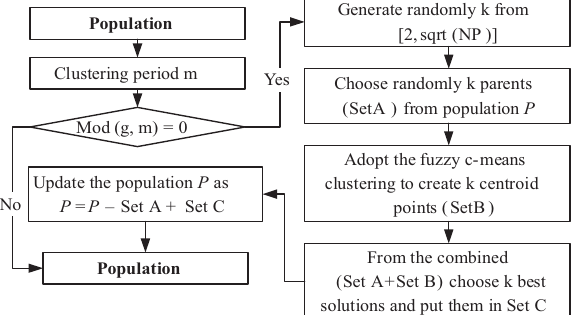
Population Fig. 3. Fuzzy c-means clustering algorithm